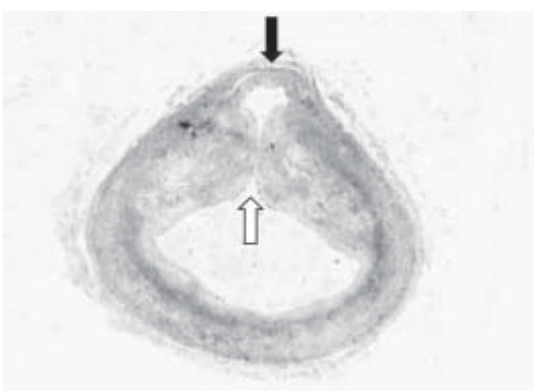
Fig. 1 - Transversal section of the coronary artery demonstrating the injuries caused by stent expansion (the stent was removed for fixing). There is rupture of the atherosclerotic plaque (white arrow) and the tunica media (black